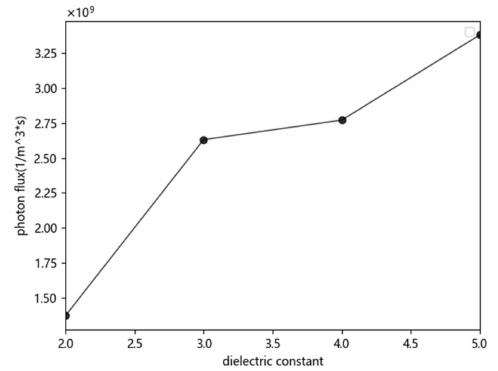
Figure 13. Variation of electric field strength with ε r .